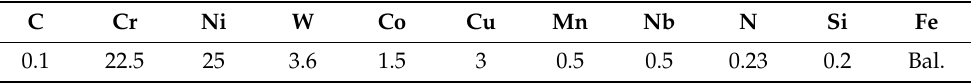
Table 1. The chemical composition of Sanicro 25 in wt % provided by